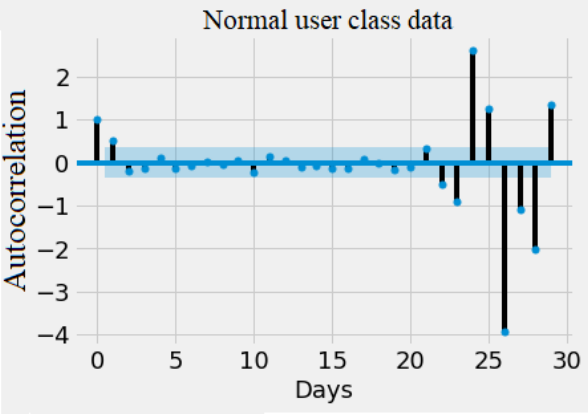
Figure 7. Data Distribution of normal users.